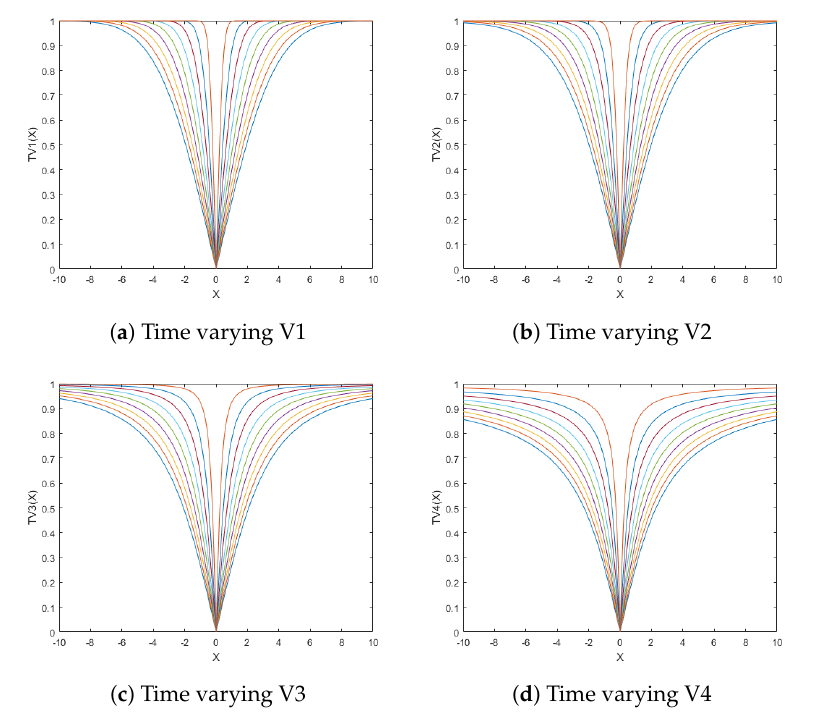
Figure 3. Behaviors of V-shaped TFs with time varying approach over 10 iterations ( τ decreased linearly from τ max = 4 to τ min = 0.01). Algorithm 1 Pseudo-code of the BHHO